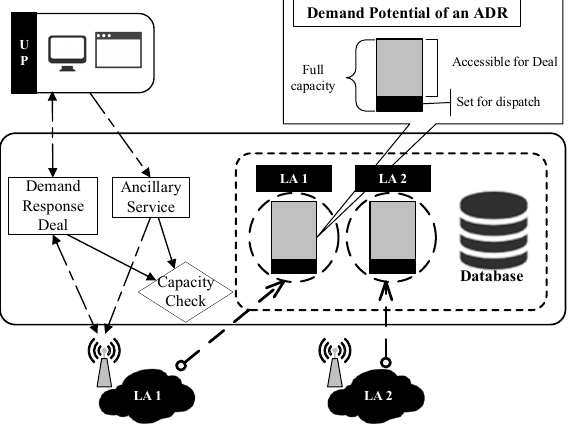
Figure 3. Diagram of potential assessment of demand response automatic server (DRAS).